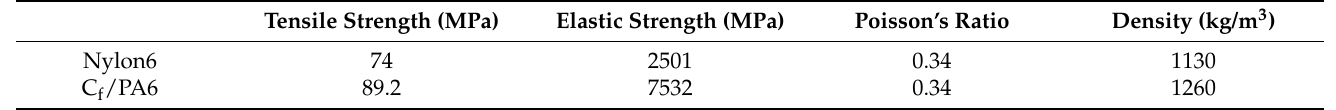
Table 1. Mechanical properties of molded 2.3-mm-thick Cf/Nylon 6 composite coupons. Tensile Strength (MPa) Elastic Strength (MPa) Poisson’s Ratio Density (kg/m 3 ) Nylon6 74 2501 0.34 1130 C f /PA6 89.2 7532 0.34